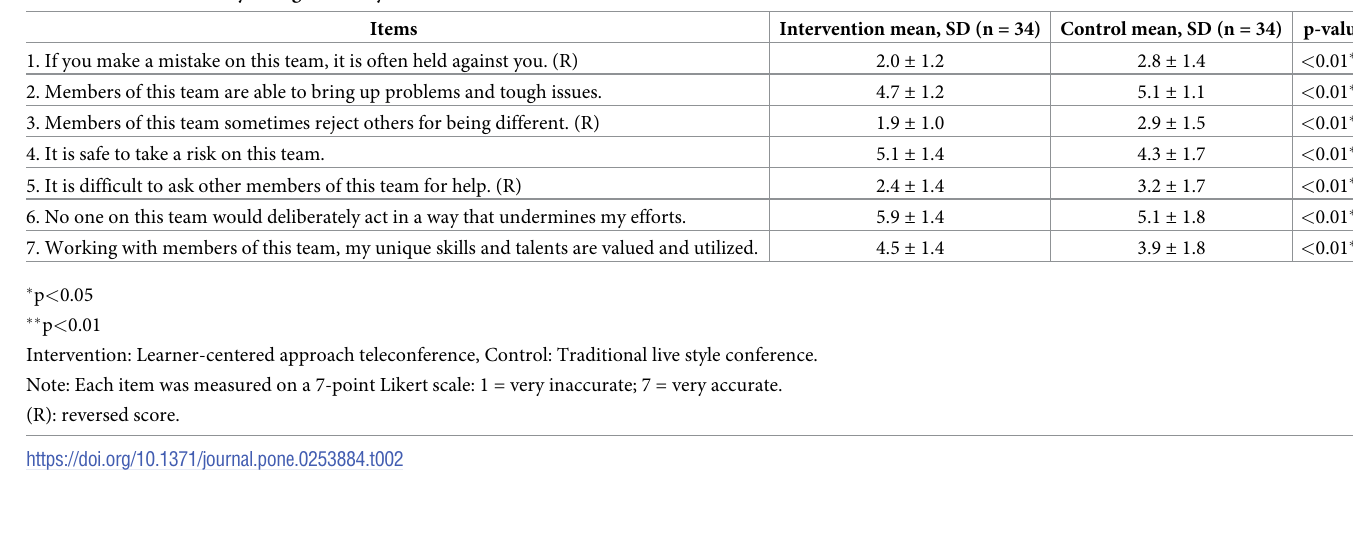
Table 2. Edmondson’s Psychological Safety